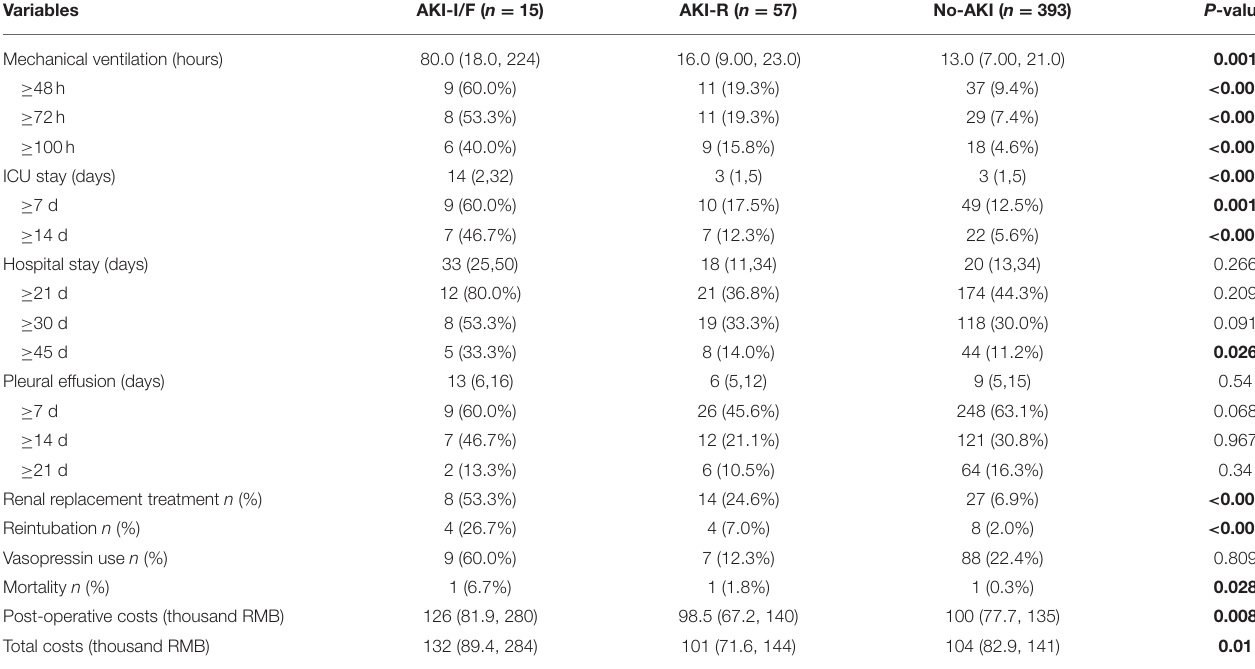
TABLE 3 | Post-operative short-term outcomes in the study patients.